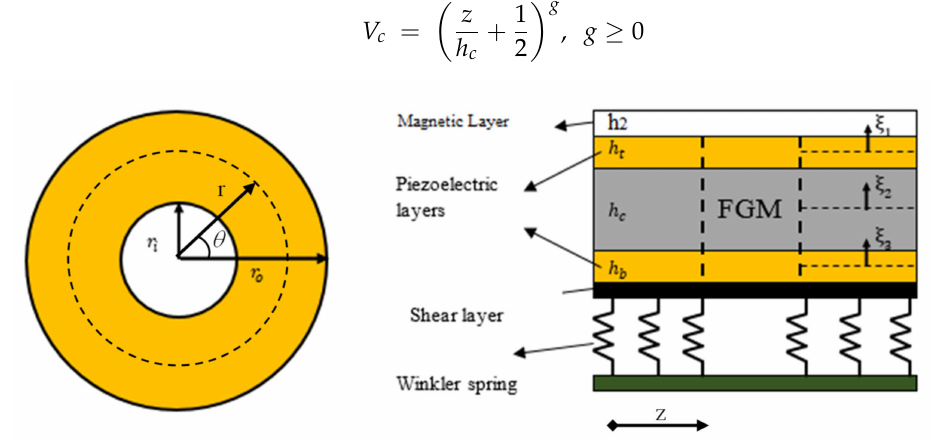
Figure 1. Configuration and coordinate system of an annular sandwich